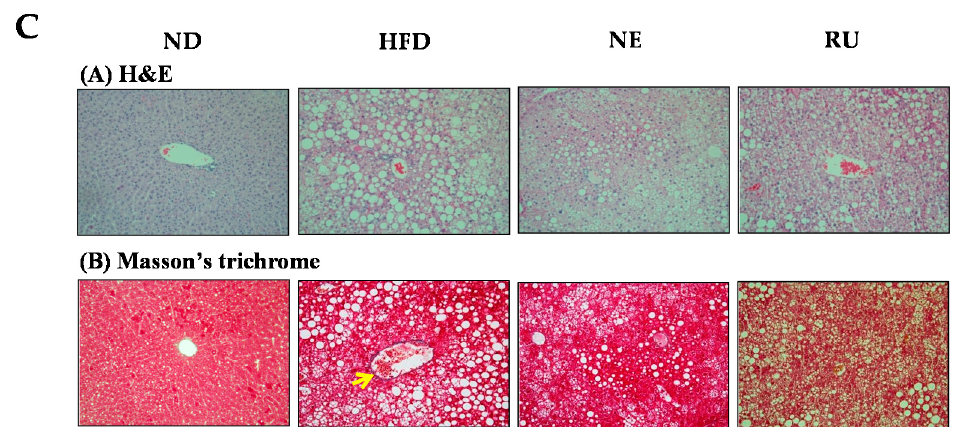
Figure 2. Effect of NE and RU supplementation for 16 weeks on liver weight ( A ), hepatic lipid profiles ( B ) and hepatic morphology (200× magnification) ( C ) in C57BL/6J mice fed high-fat diet. Data are mean±S.E. Significant differences between HFD vs. ND are indicated; *** p < 0.001. ab Means not sharing a common superscript are significantly different among the high-fat diet fed groups at p < 0.05.